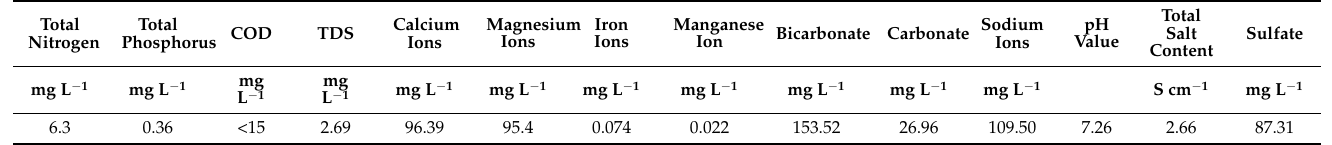
Table 2. Test of water